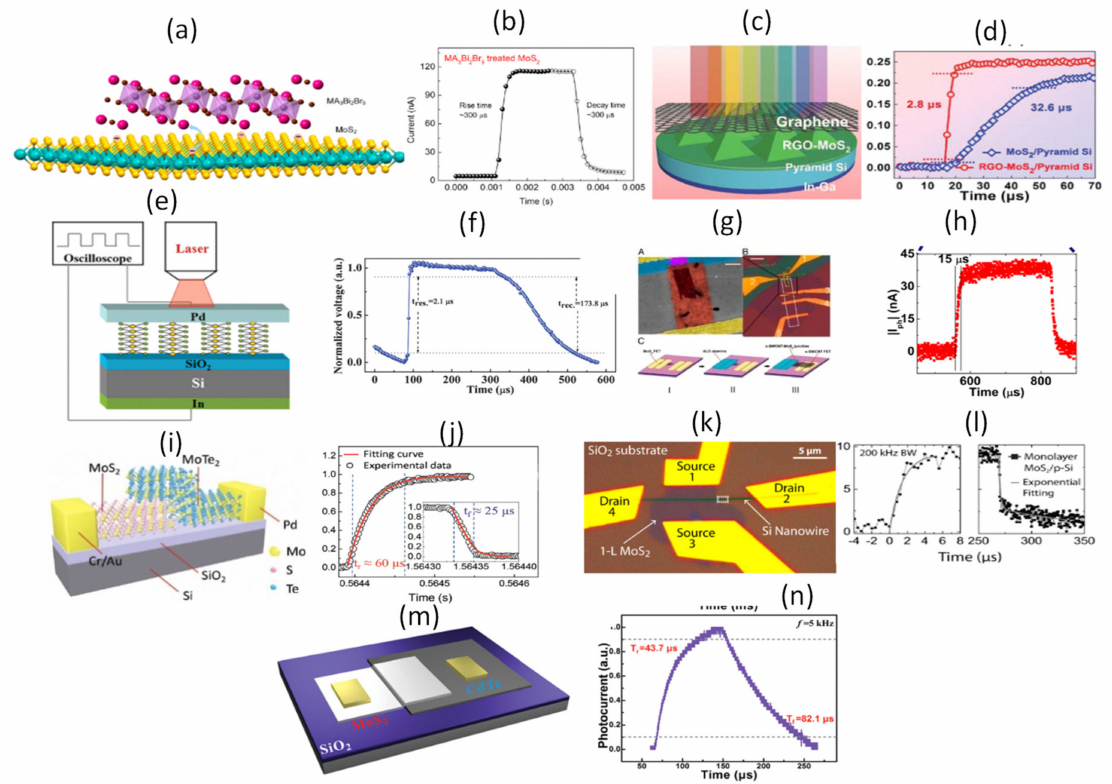
Figure 12. ( a , b ) Schematic diagram of MoS 2 and MA 3 Bi 2 Br 9 hetero-structure, Rise and decay time of MA 3 Bi 2 Br 9 -treated MoS 2 device irradiated by 530 nm LED with a power density of 3.3 mW / cm 2 . Reproduced with permission from reference [145]. ( c , d ) Schematic illustration of the structure of 3D RGO–MoS 2 / pyramid Si hetero-junction photodetector, rise edges, Reproduced with permission from reference [146], ( e , f ) Schematic illustration of the setup for measuring the response time of the Pd-MoS 2 / Si device, Single normalized modulation cycle measured at 2000 Hz. Reproduced with permission from reference [147]. ( g , h ) False-colored SEM image of the hetero-junction diode. (Scale bar, 2.5 µ m.) The yellow regions at the top and bottom are the gold electrodes. The patterned alumina (blue region) serves as a mask for insulating a portion of the SL-MoS 2 flake (violet region). The pink region is the patterned random network of s-SWCNTs (p-type) in direct contact with the exposed part of the SL-MoS 2 flake (n-type) to form the p-n hetero-junction diode (dark red), Time- dependent photoresponse of the p-n hetero-junction showing fast rise and decay times of ~15 µ s, Reproduced with permission reference [148]. ( i , j ) Schematic diagram of the MoTe 2 / MoS 2 van der Waals hetero-structure, Time resolved photoresponse of the hetero-structure at V sd ≤ 0.51 V. The inset is falling edge of the response, Reproduced with permission from reference [152]. ( k , l ) Optical micrograph of a device in which a MoS 2 monolayer was transferred onto a p-Si nanowire followed by contact fabrication, Transient photocurrent of monolayer MoS 2 / Si nanowire p-n hetero-junction (black squares) measured with a high-speed current preamplifier (200 kHz bandwidth) at VD = − 8 V. Rise and fall times are fit with single and bi-exponentials (gray lines), and equal t rise = 1.4 µ s and t fall = 1.6 µ s (80 µ s), respectively. Reproduced with permission from reference [159]. ( m , n ) Schematic illustration of a MoS 2 / CdTe hetero-junction device, Rising and falling edges for estimating the rise time and the fall time at 5 kHz. Reproduced with permission from reference